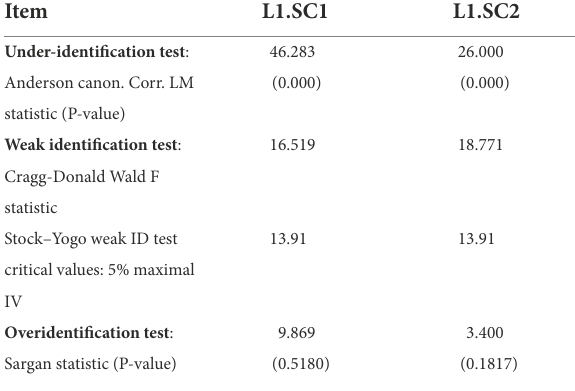
TABLE 5 Supplier concentration and corporate innovation. TABLE 6 Validity test of instrumental variable.